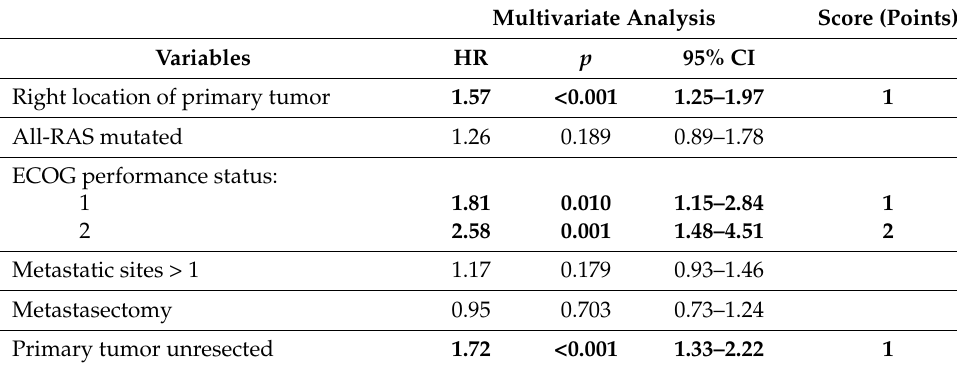
Table 3. Multivariate model for prognostic factors and Score construction. Significant associations are written in bold.